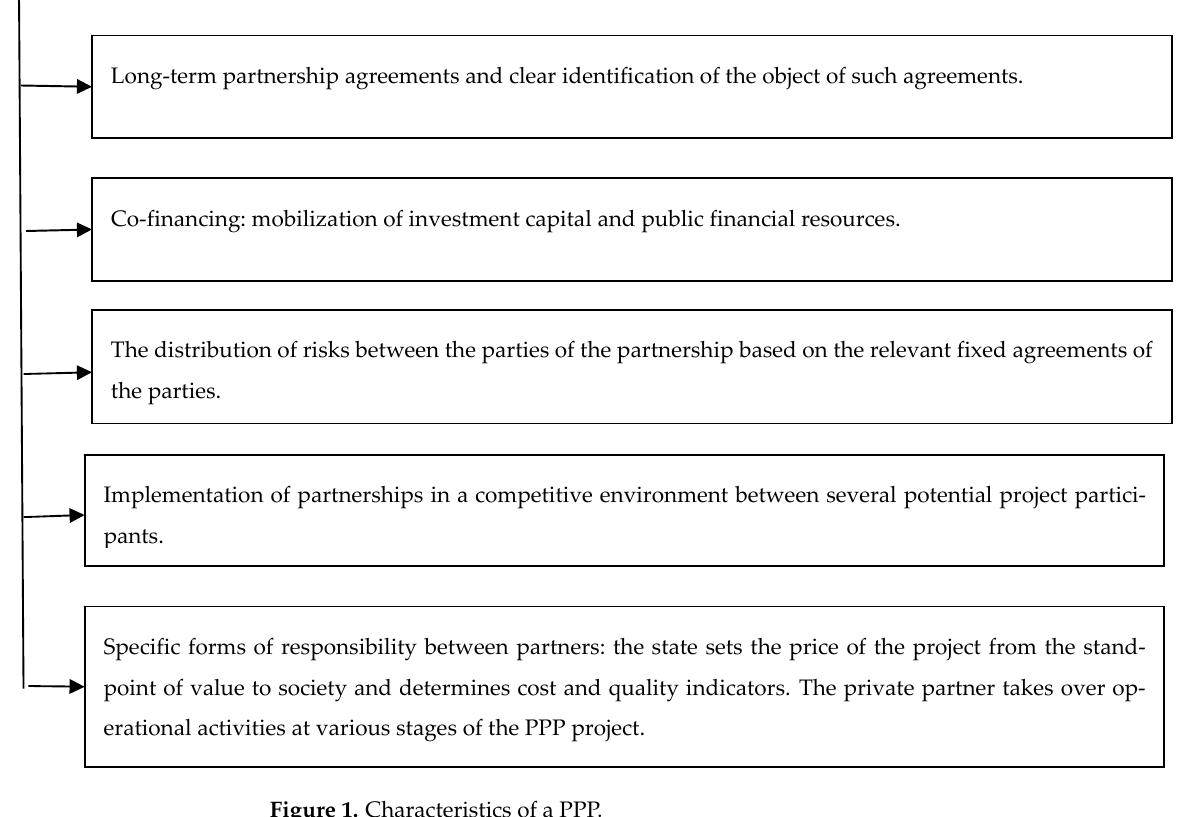
Figure 1. Characteristics of a PPP.